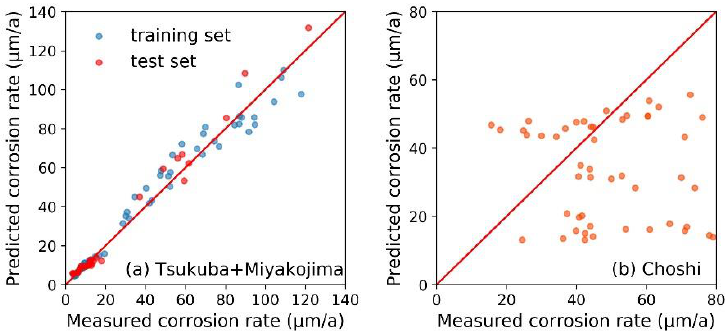
Figure 5. The random forest algorithm-based corrosion rate prediction model for steel samples under the open environment. ( a ) The model was trained and tested by the corrosion data of Tsukuba and Miyakojima. ( b ) The model’s generalization ability was evaluated by verifying its prediction accuracy to the same steel samples in Choshi.